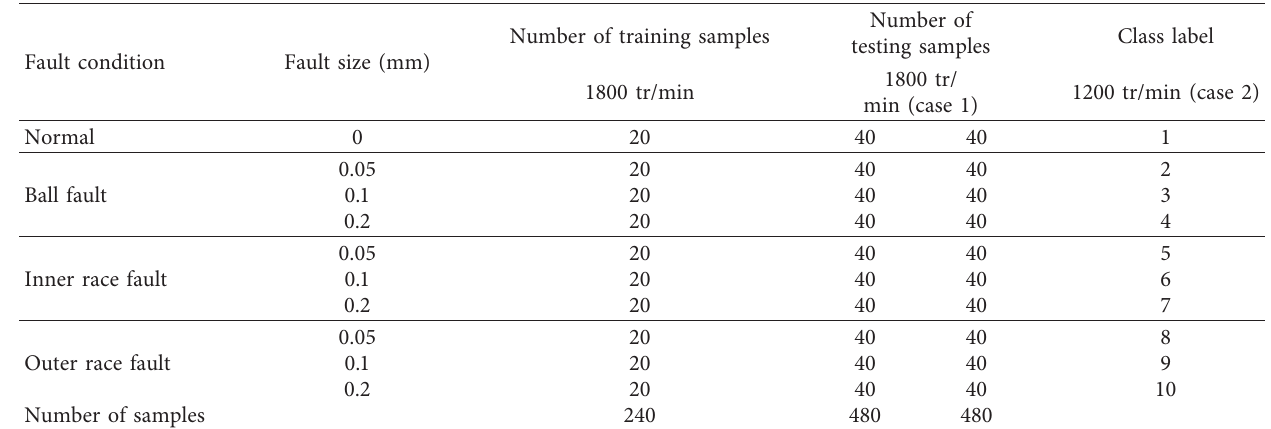
Table 13: The introduction of experimental